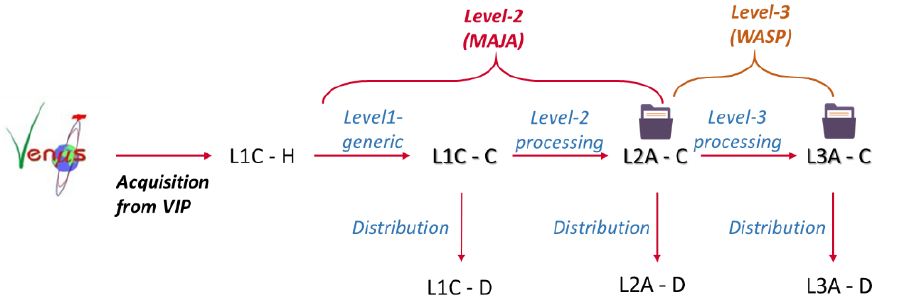
Figure 43. THEIA processing for VEN µ S (all levels: https://theia.cnes.fr/atdistrib/rocket/#/home, accessed on 21 June 2022, Level-2 and Level-3: https://catalogue.theia-land.fr/, accessed on 2 M arch 2022).